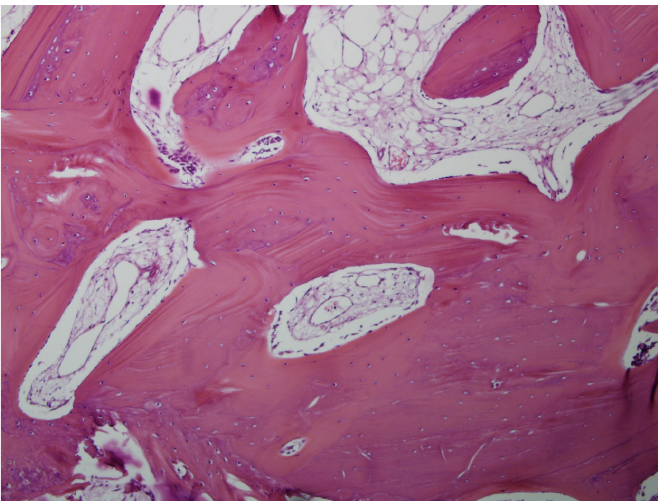
FIGURE 1 - Histologic section of the operated hemimandible of cat 2 of group 1 shows the osteotomy line at 12 weeks postoperative bridged by woven bone. Demineralised bone specimen. (HE